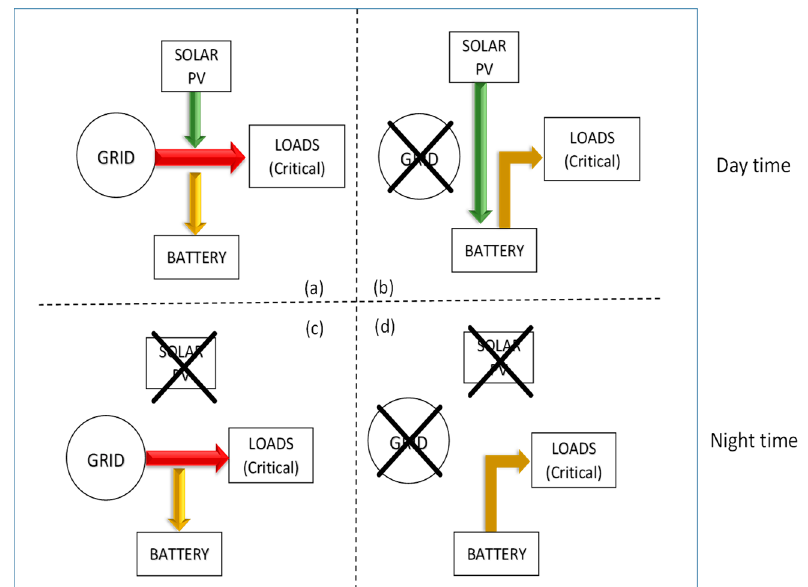
Figure 1. ( a ) Typical power flow diagram for a residential house with photovoltaic (PV) integrated into backup settings. ( b ) Day time operation with grid unavailable. ( c ) Night time operation with grid available. ( d ) Night time operation with grid unavailable.